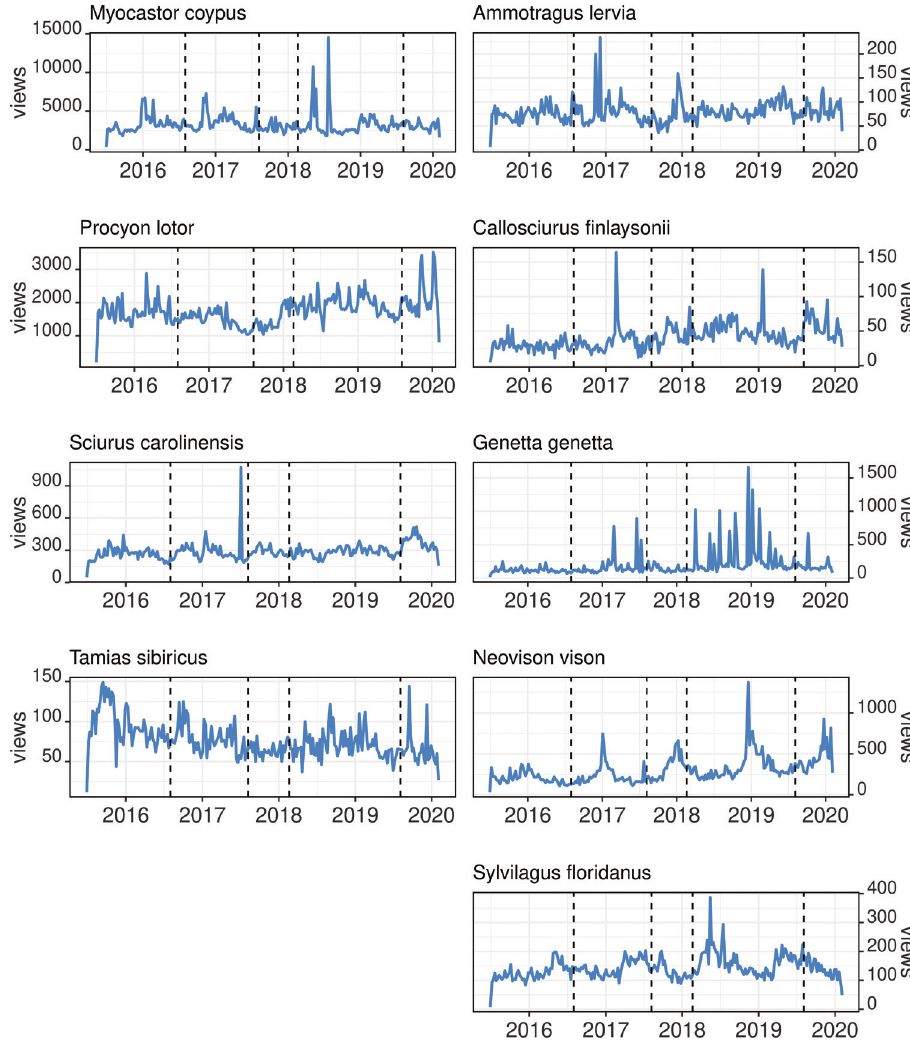
Figure 4. Number of visits to Wikipedia pages on invasive alien mammals included in the Union list (left column) and invasive alien mammals not included in the list (right column). Dashed lines, from left to right, represent the publication of the first blacklist (July 2016), its first update (July 2017), the implementation of the first Italian law about invasive species (February 2018) and the second update of the blacklist (July